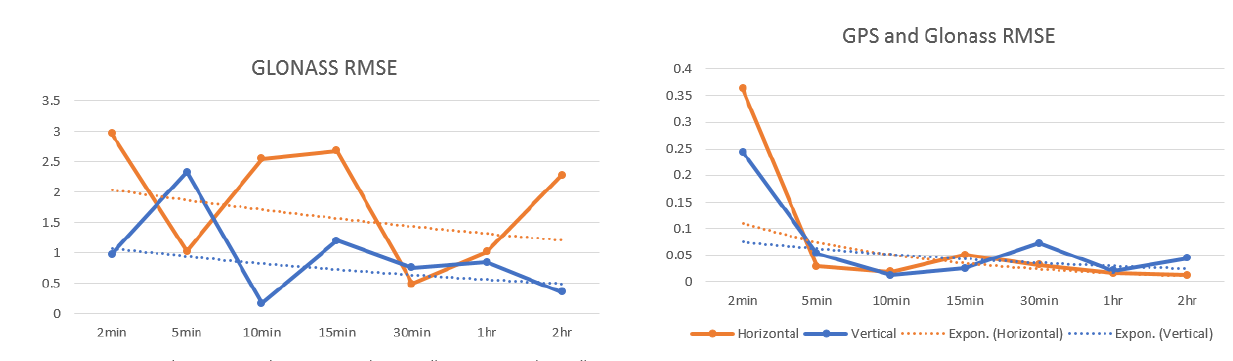
Figure 11. RMSE of horizontal and vertical observations using GPS only. Y-axis in meters.